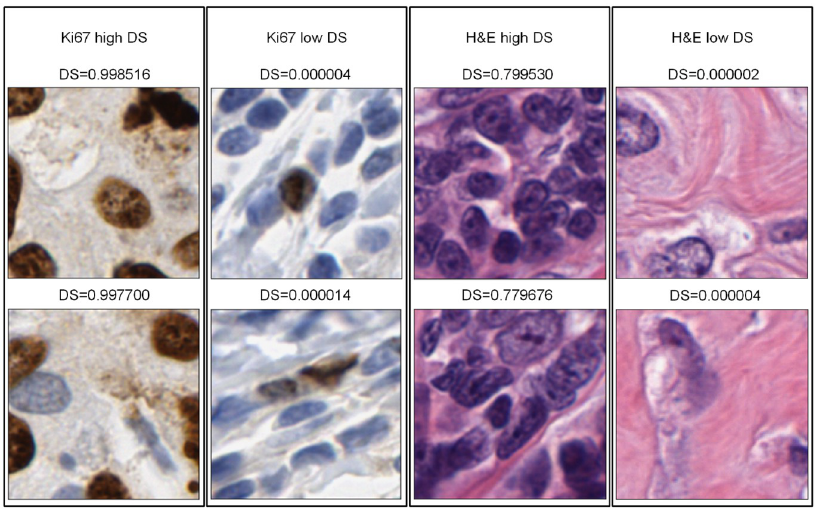
Fig 7. Example scoring results of Ki67 and H&E patches. Examples were selected among patches who received top 50 high DSs and bottom 50 low DSs in their slides from the CNN-scorer. DSs are ranged from 0 to 1. The higher the DS is, the more discriminative the DS